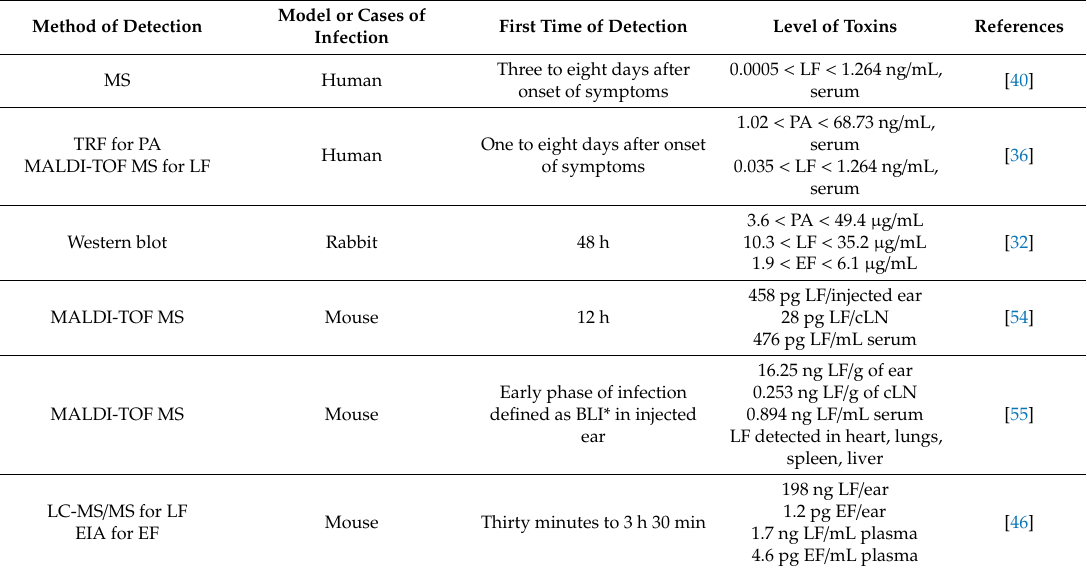
Table 3. First detection of PA, LF, and EF in humans with cutaneous anthrax and in animal models of cutaneous anthrax (*BLI: